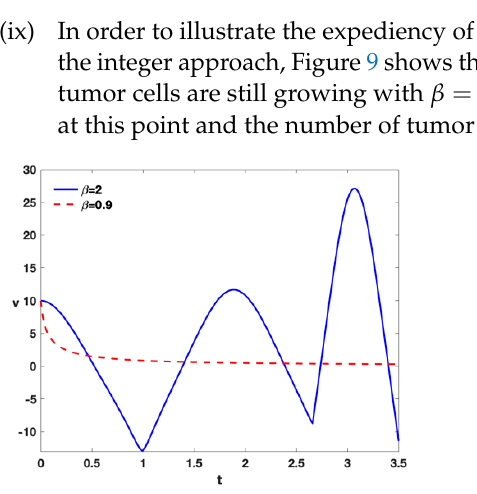
Figure 9. Time series of tumor cells with a = 0.9, m 1 = 1, k 1 = 0.5, b = 1, c = 3, d = 2.5, k 2 = 1,